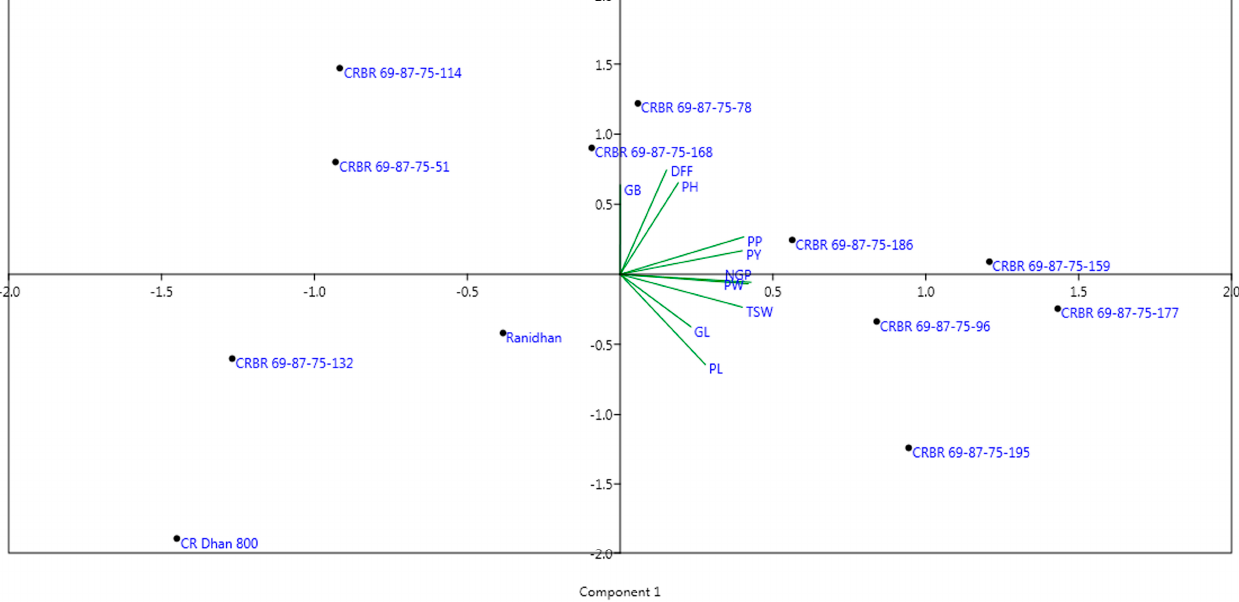
Figure 6. Biplot diagram generated using the 10 traits for yield, agro-morpholic and grain quality characters of the pyramided and parental lines.